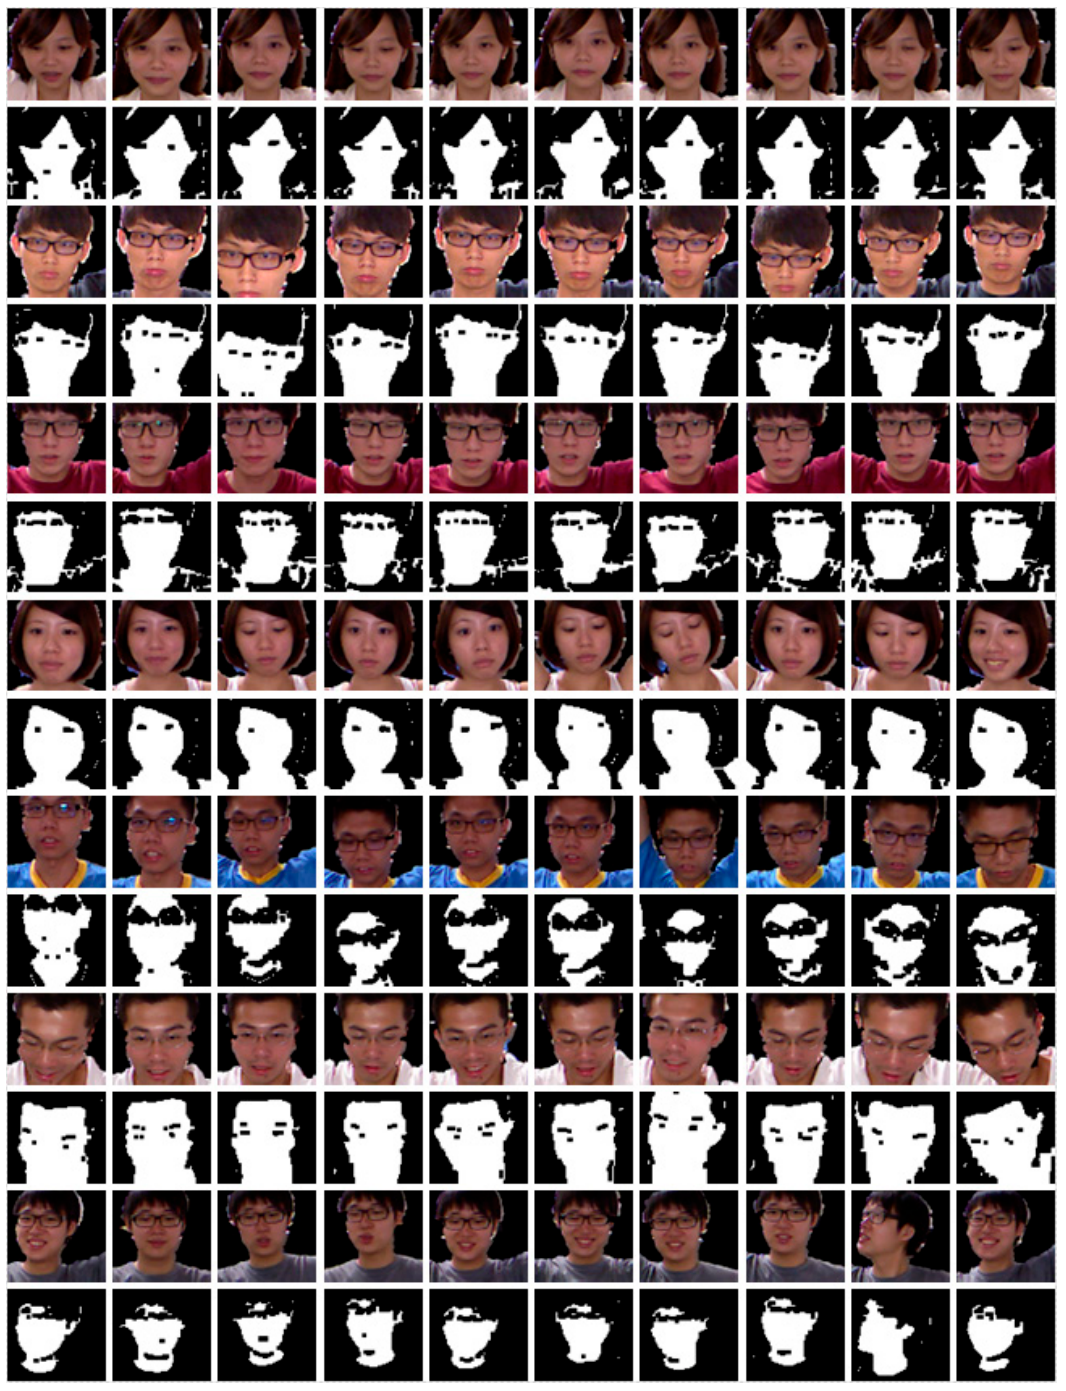
Figure 16. Results of test samples 8–14.